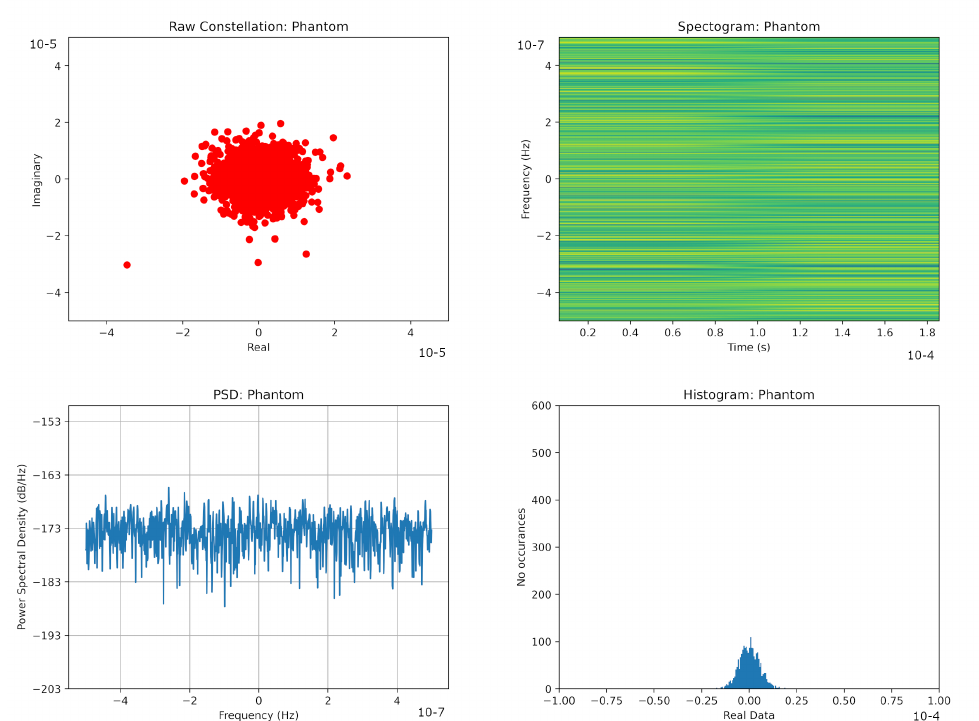
Figure 12. AR Mode 3—Phantom Mode 3—switched